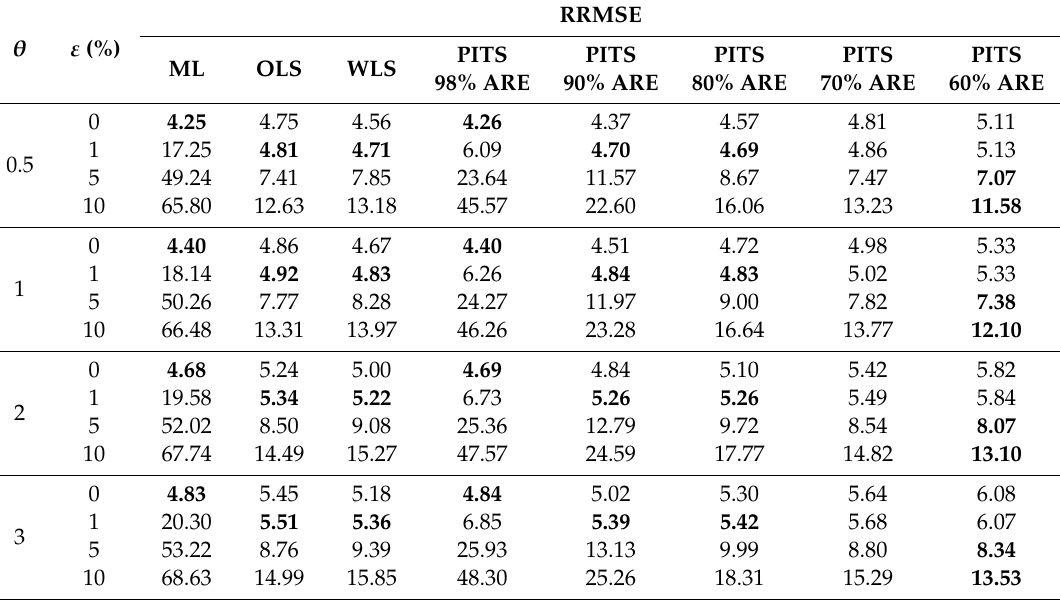
Table 7. RRMSE results for estimations of parameter θ with n = 300 and ε = 0%, 1%, 5%, 10%.